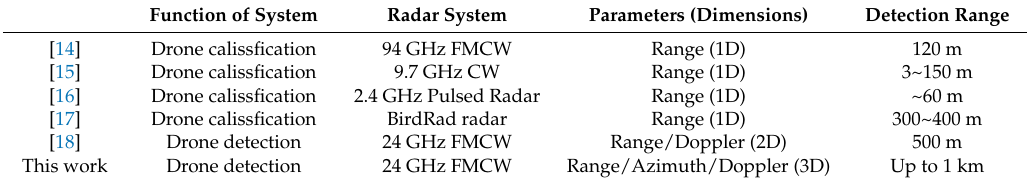
Table 1. Comparison of drone classification/detection with the previous works.